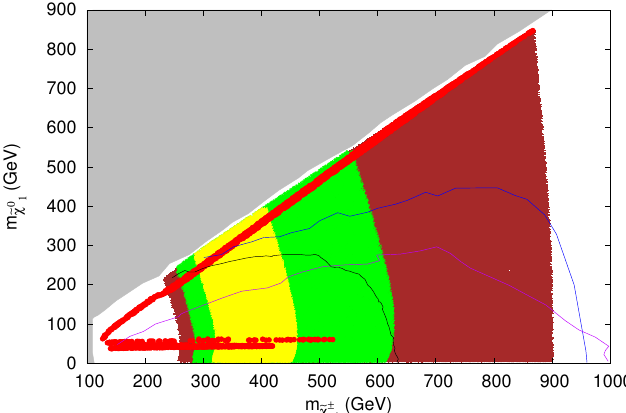
Figure 7 . Exclusion contours in the m (LMLS) model. The blue (black) line represents exclusion obtained by us [10] using the ATLAS 3 l + E= T search data from Run II (Run I). The exclusion from the direct slepton search (the magenta curve) is also shown. Colors and conventions are same as in (cid:12)gure 1.